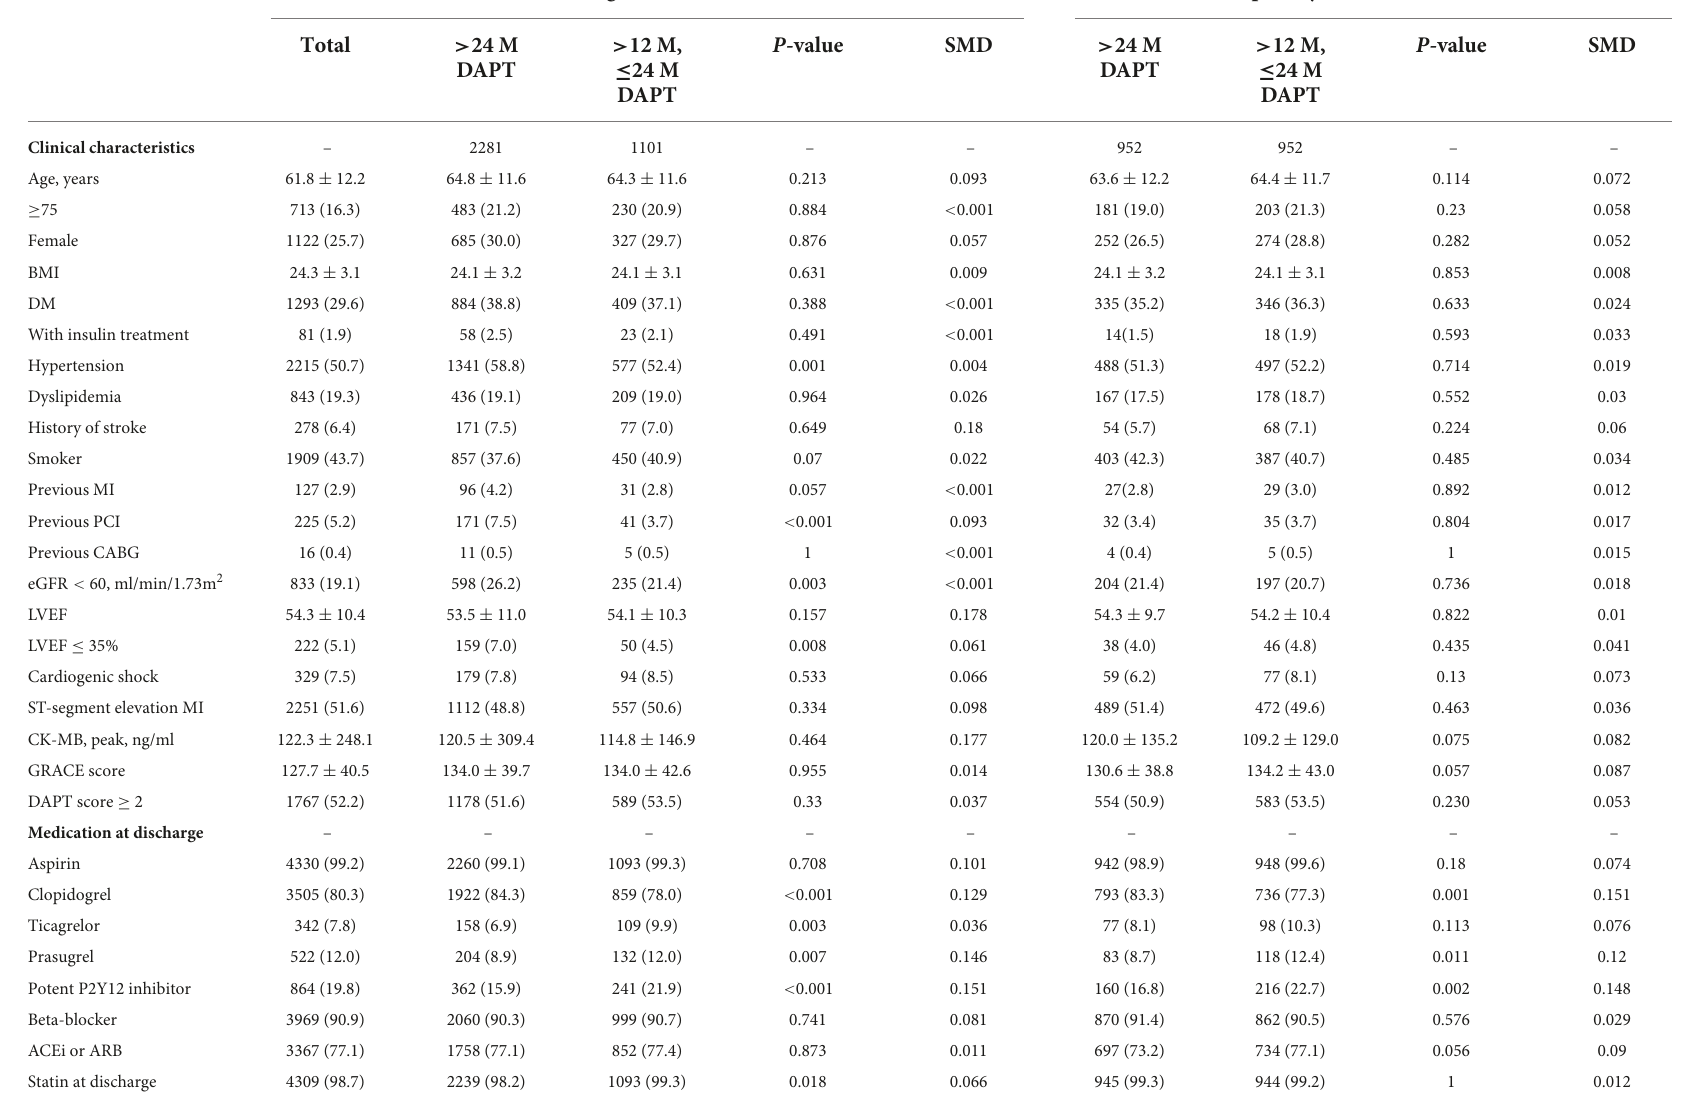
TABLE 1 Baseline